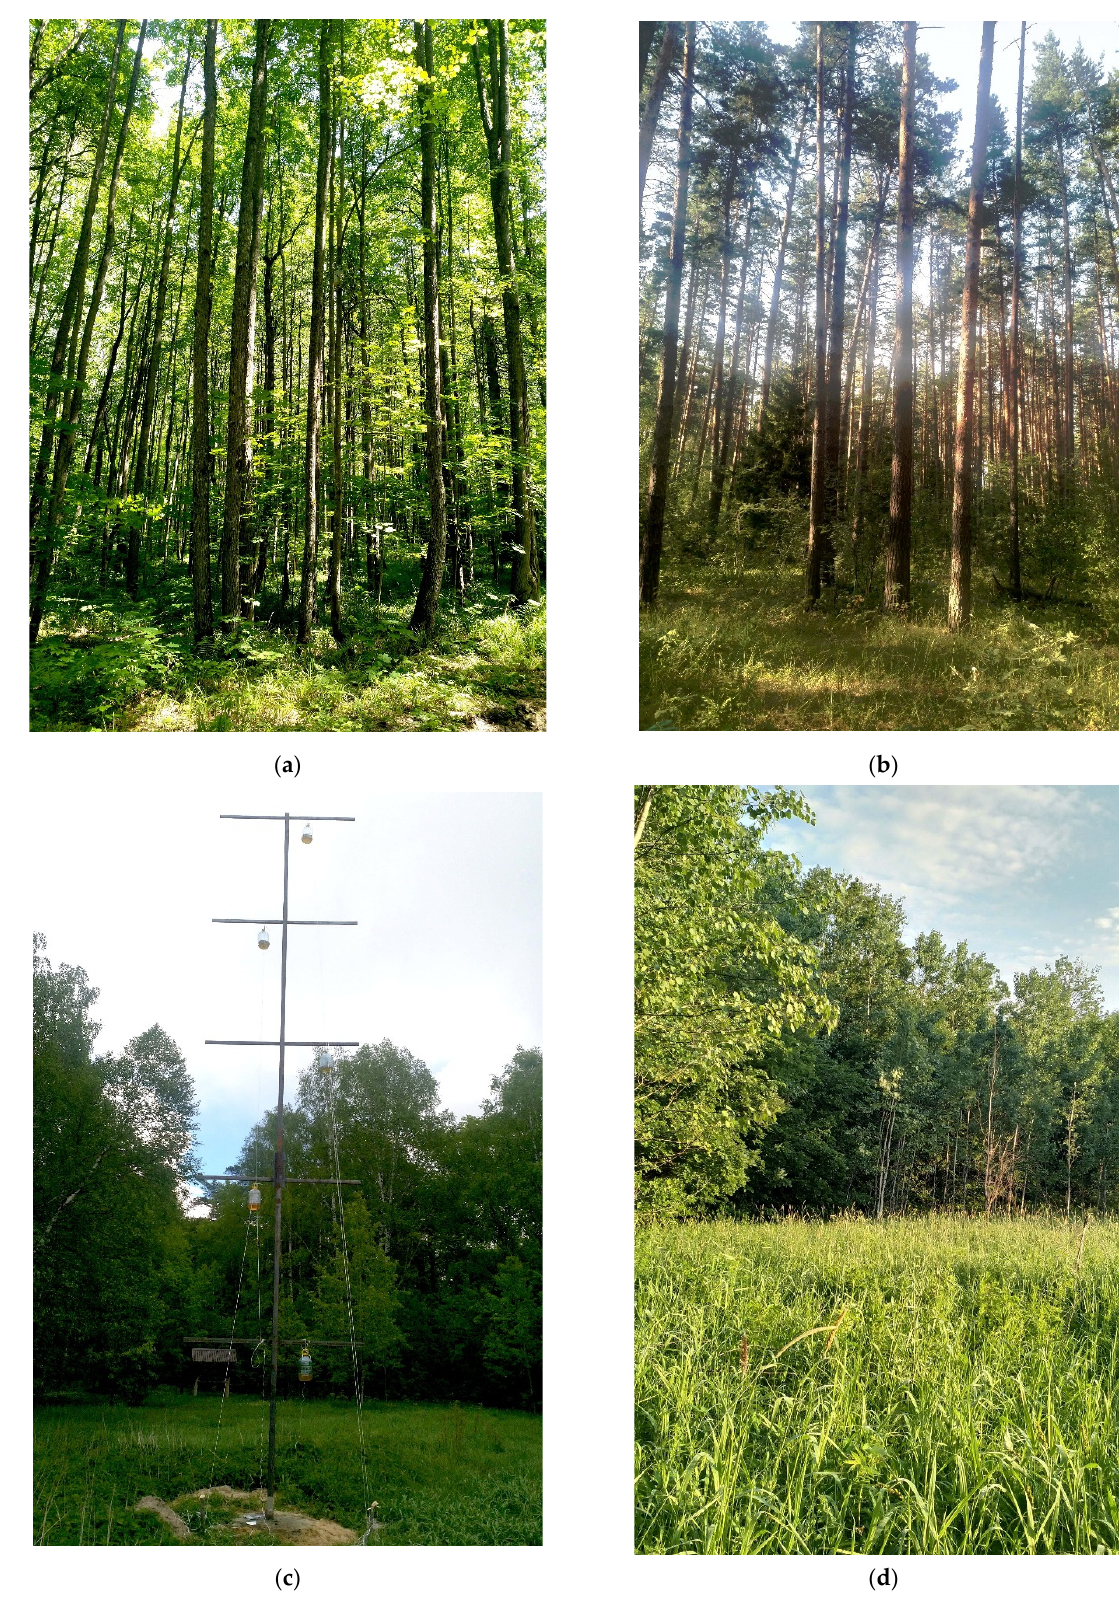
Figure 1. Photos of the study sites. Description of biotopes in the text: ( a )—deciduous forest; ( b )—pine forest; ( c )—glade in the forest with a research installation; ( d )—edge of deciduous forest (all photos made by A.B.